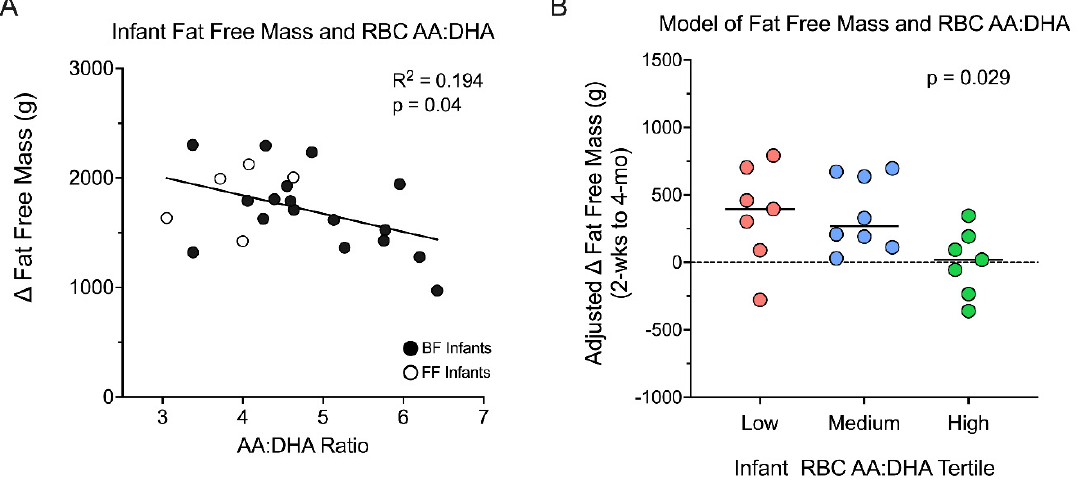
Figure 2. The lower the infant RBC total fatty acid AA/DHA ratio, the greater the infant ∆ -FFM/day. ( A ) The change in infant FFM and the RBC AA:DHA ratio is inversely correlated ( p = 0.04, R 2 = 0.194), such that as the ratio of AA:DHA in the infant goes up, the less FFM the infant develops. ( B ) Adjusted change in infant FFM in grams is significantly lower in the high AA:DHA infant tertile when controlling for infant sex, infant adiposity at 2 weeks old, and infant feeding type ( p = 0.029). 3.6. Infant RBC Phospholipid Species Containing AA and DHA Correlate with Changes Infant Fat-Free Mass Accumulation